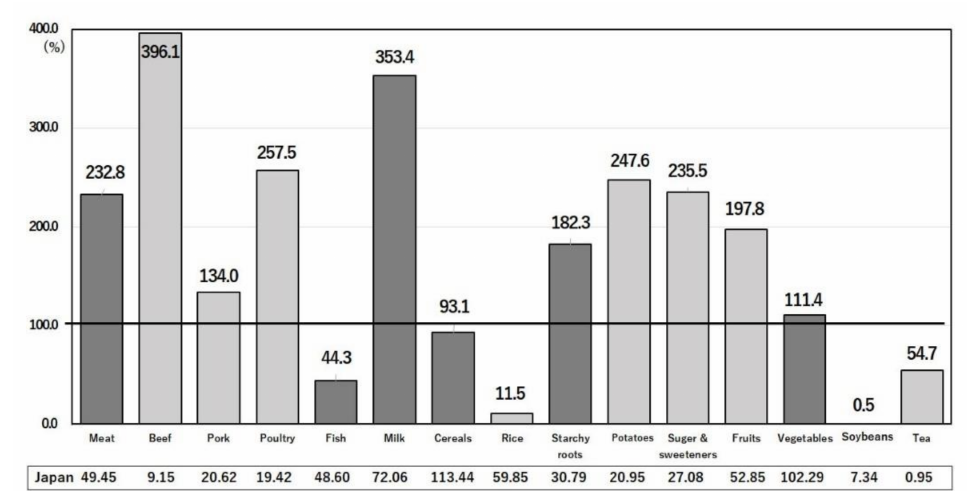
Figure 8. Comparison of food intakes between Japan and the U.S. The value of each item (kg/capita/year) in Japan was taken as 100%. The actual Japanese values are shown below each bar. Data available at http://www.fao.org/faostat/en/#home (accessed 10 December 2021).